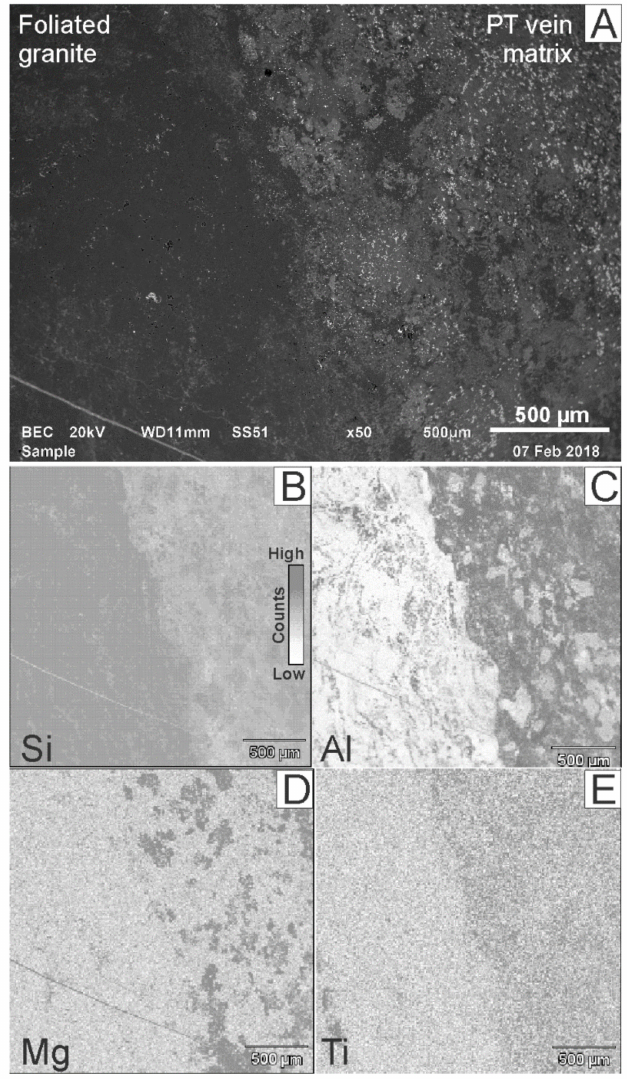
Figure 7. BSE image and EDX maps of the PT vein in contact with foliated granite. ( A ) BSE image. ( B ) EDX intensity map of Si, showing that the granite is enriched in Si compared to the PT vein. ( C ) EDX intensity map of Al, showing that the PT vein is enriched in Al and that Al is inhomogeneously distributed in the PT vein. ( D ) EDX intensity map of Mg, showing that the PT vein is enriched in Mg. ( E ) EDX intensity map of Ti, showing that the PT vein is enriched in